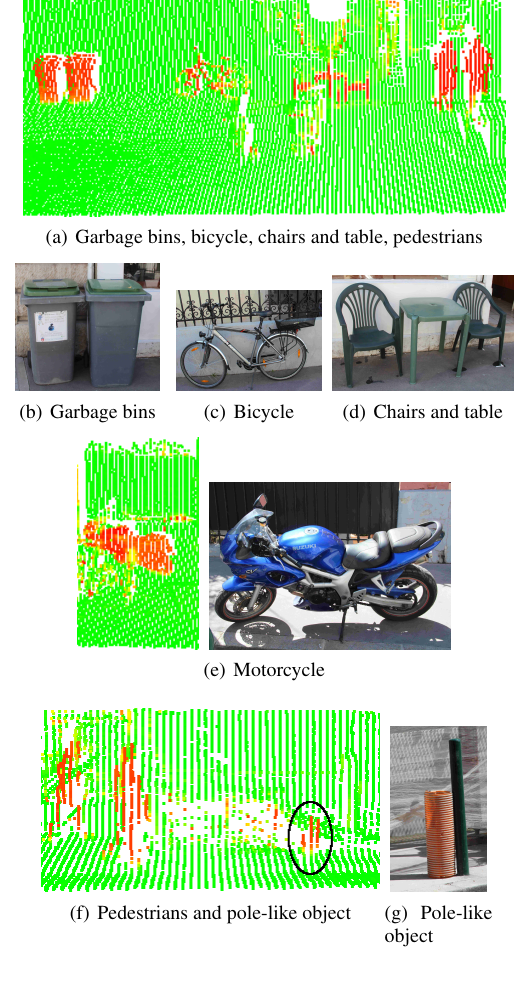
Figure 11: Detected changed urban